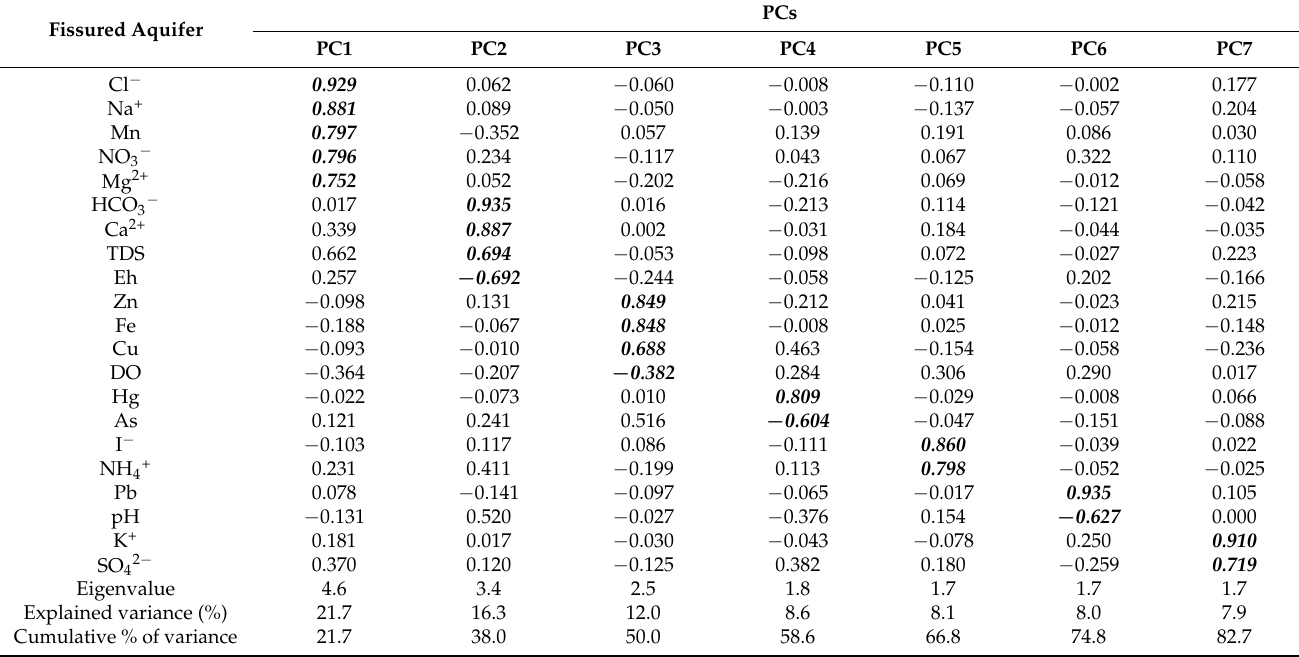
Table 4. Principal component (PC) loadings for groundwater chemistry in fissured aquifers in agricultural lands in the Pearl River Delta. Fissured